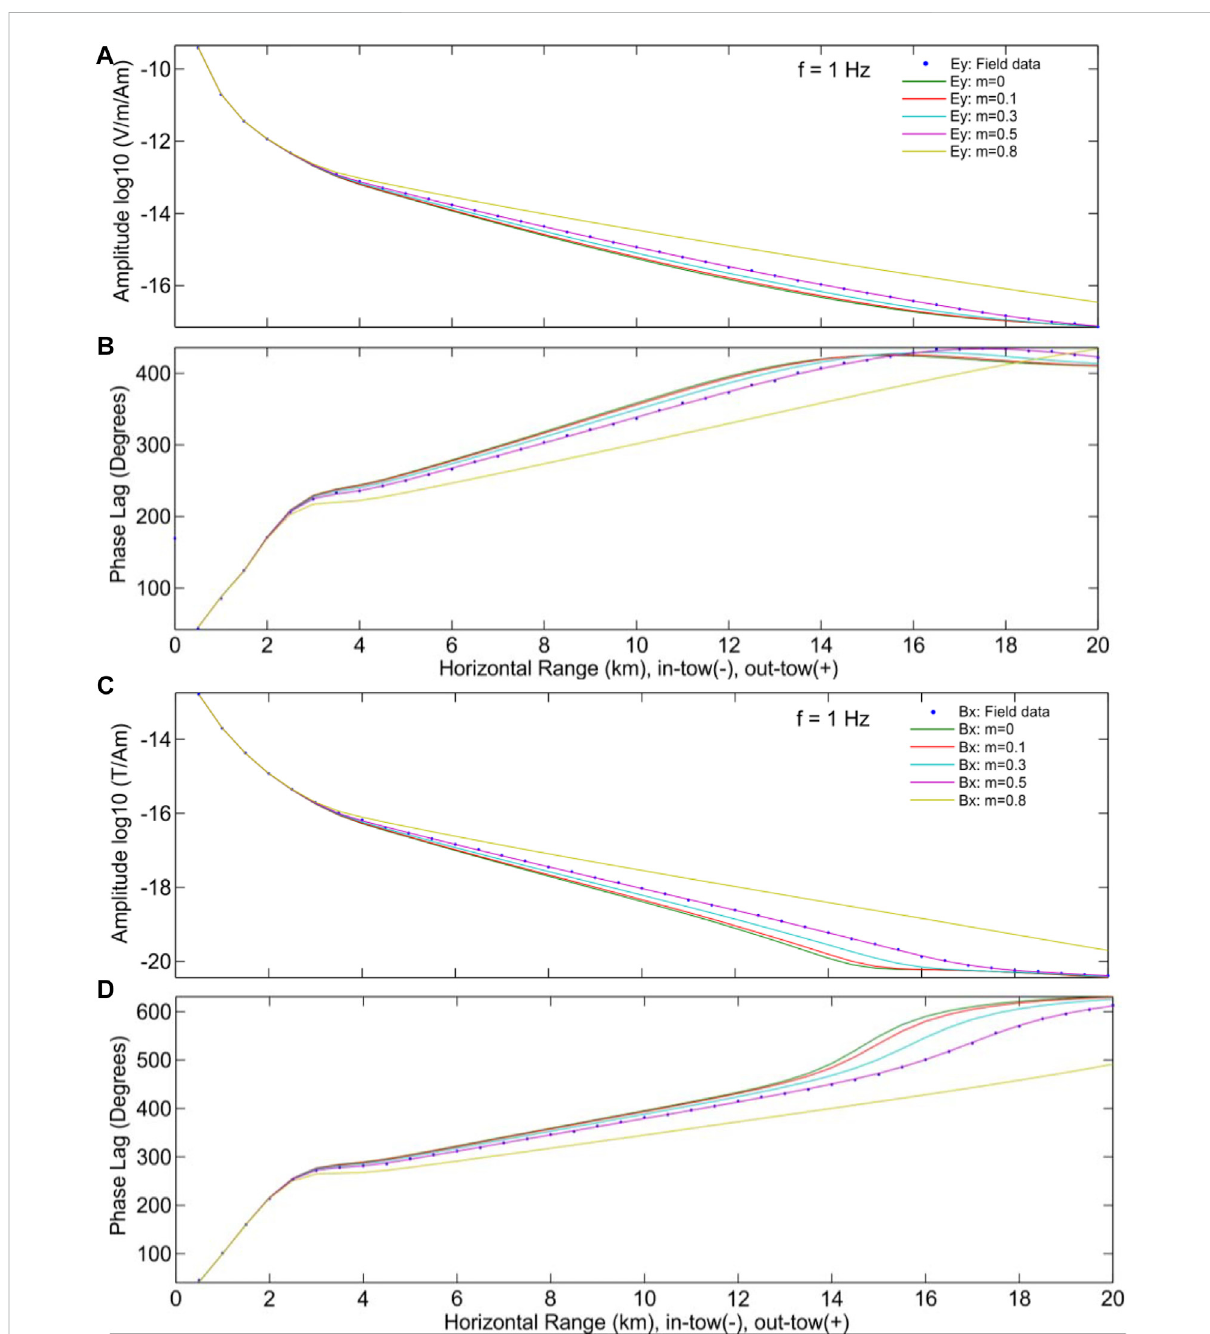
FIGURE 15 Log10 amplitude and phase (degrees) of f = 1 Hz CSEM fi eld data [Ey (A,B) and Bx (C,D) ]. Field data (blue) and inversion response with the Cole – Cole model of various polarizability m = 0 (pure electromagnetic fi eld) (green), 0.1 (red), 0.3 (light blue), 0.5 (purple), and 0.8 (yellow),